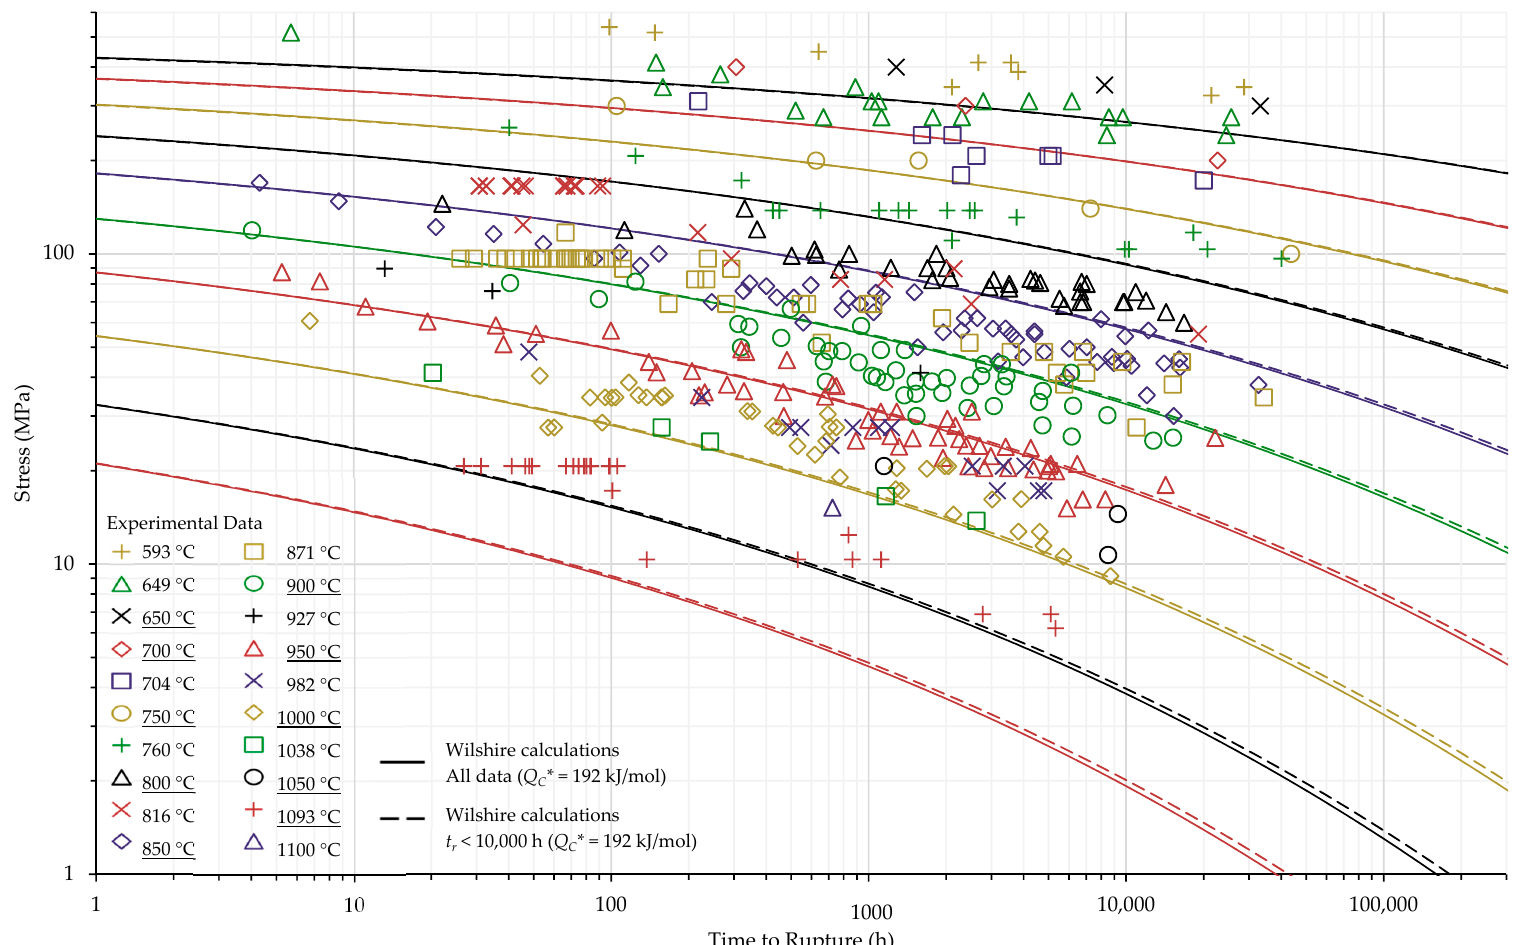
Figure A8. Single region calculations of the Wilshire equation with the self-diffusion activation energy of nickel in a nickel lattice as Q ∗ for Inconel 617 shown at underlined temperatures.